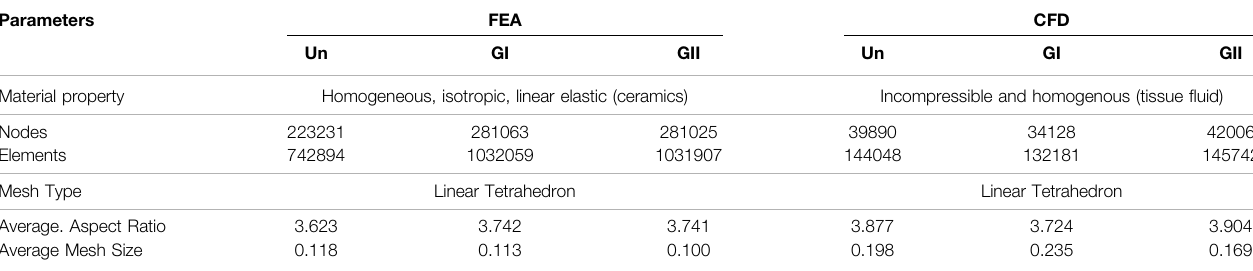
TABLE 1 | Paramters of FEA and CFD